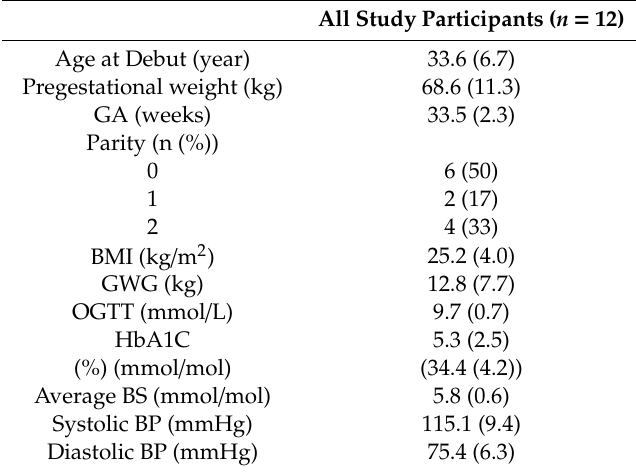
Table 3. Baseline characteristics of the participants ( n = 12) included in the final analysis.